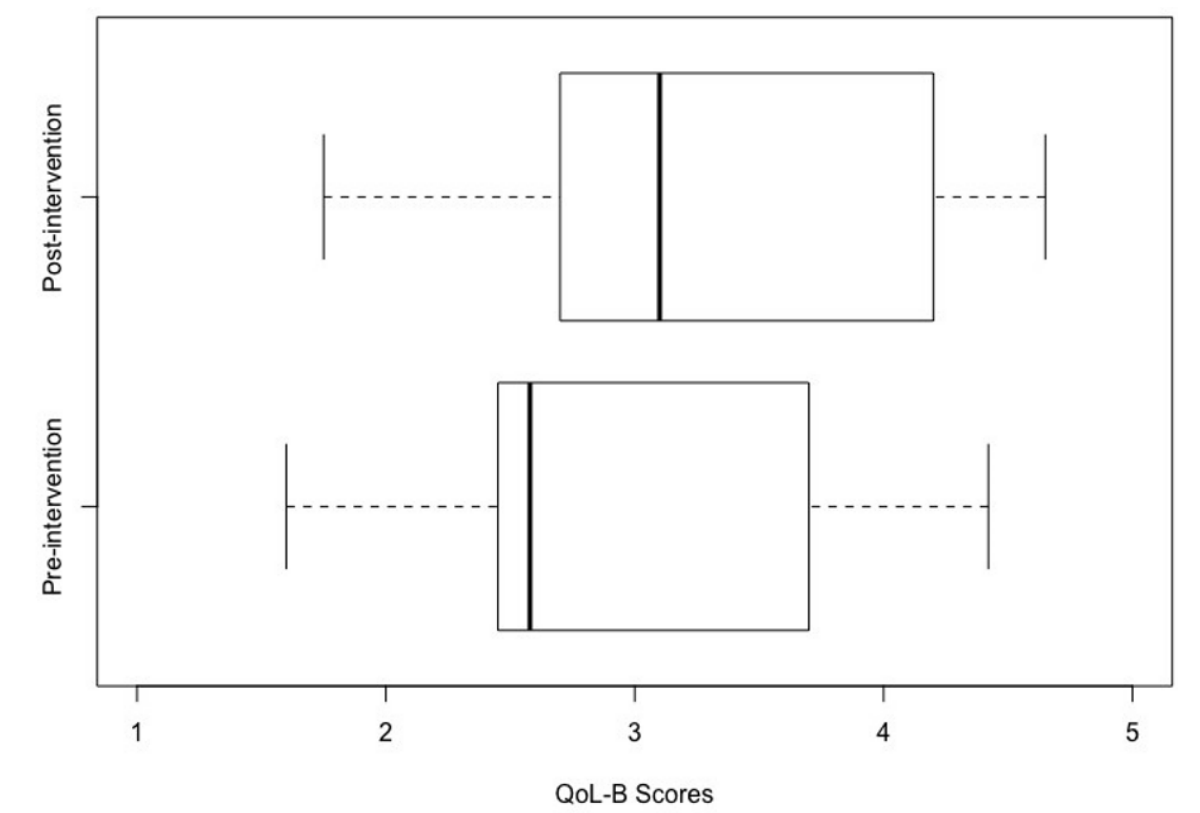
Figure 2. “Effect of Intervention on perceived autism specific difficulties scores”. Intervention (binary variable i.e., pre- and post-intervention) is plotted on the y-axis while QoLA-B scores (range: 1 to 5) are plotted on the x-axis. Note: Higher scores on x-axis reflect fewer perceived autism specific difficulties.